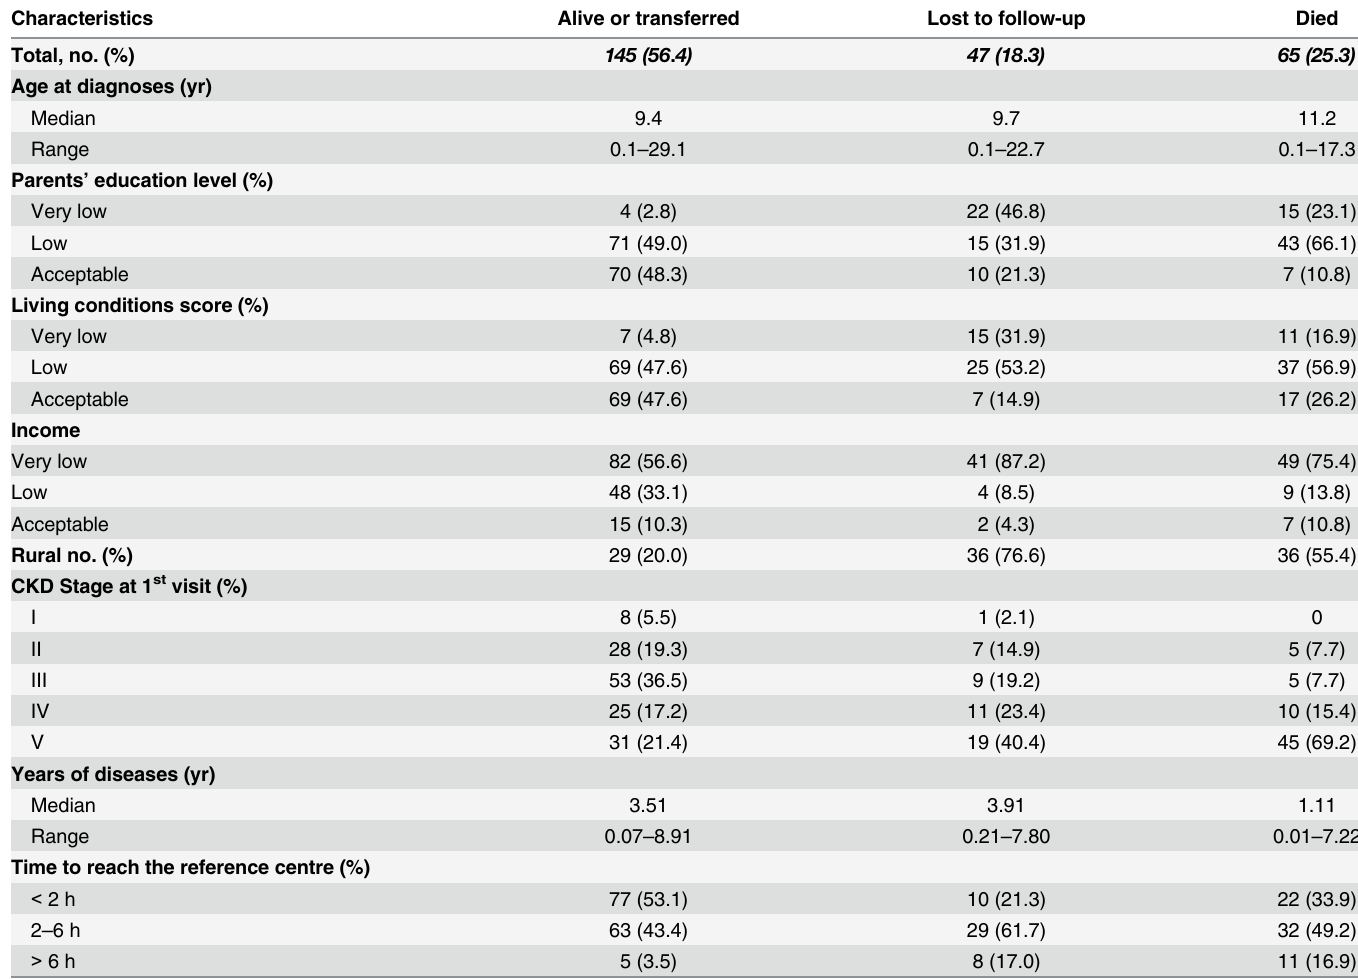
Table 3. Profile of the cohort according to its outcomes. Characteristics